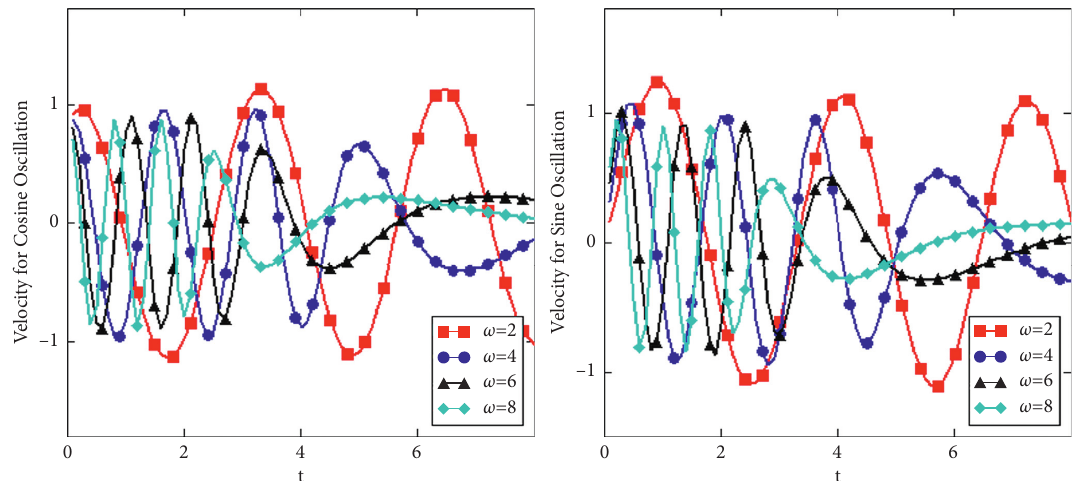
Figure 6: The variation of ω for both the oscillations with c � 2, α � 0 . 5, λ